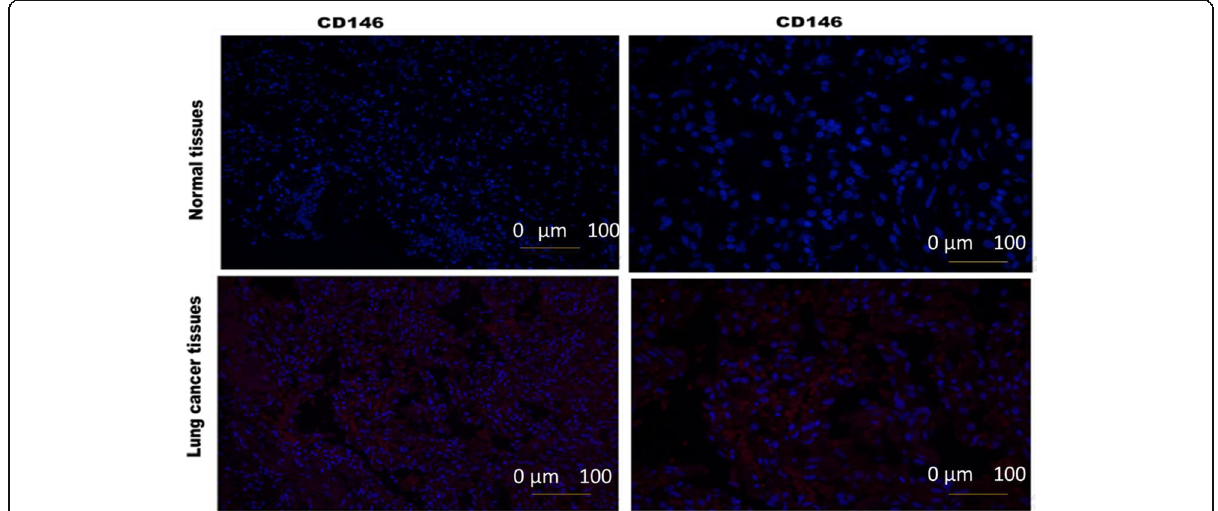
Fig. 3 CD146 expression on T cells in lung cancer patients. From the flow cytometry, the expression of the CD 146+ in the T cells includes 4.60 % in healthy patients, 10.10 %, 12.20 %, 9.80 % in adenocarcinoma, squamous and small cell lung cancer